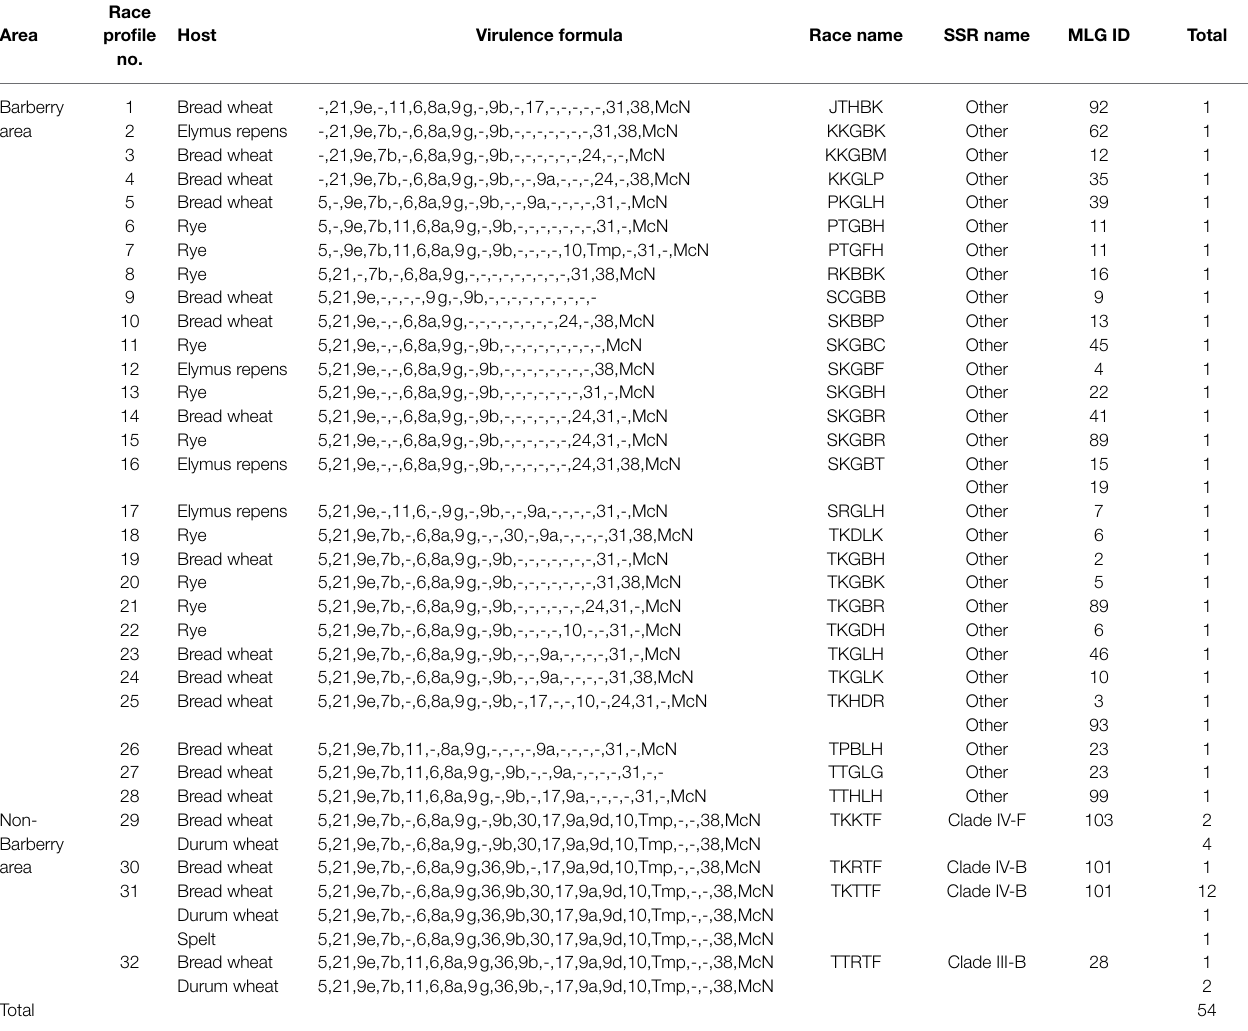
TABLE 5 | Virulence diversity of 31 races of Puccinia graminis f.sp. tritici in areas in Spain in proximity of Berberis species and in areas where the alternate host was absent.